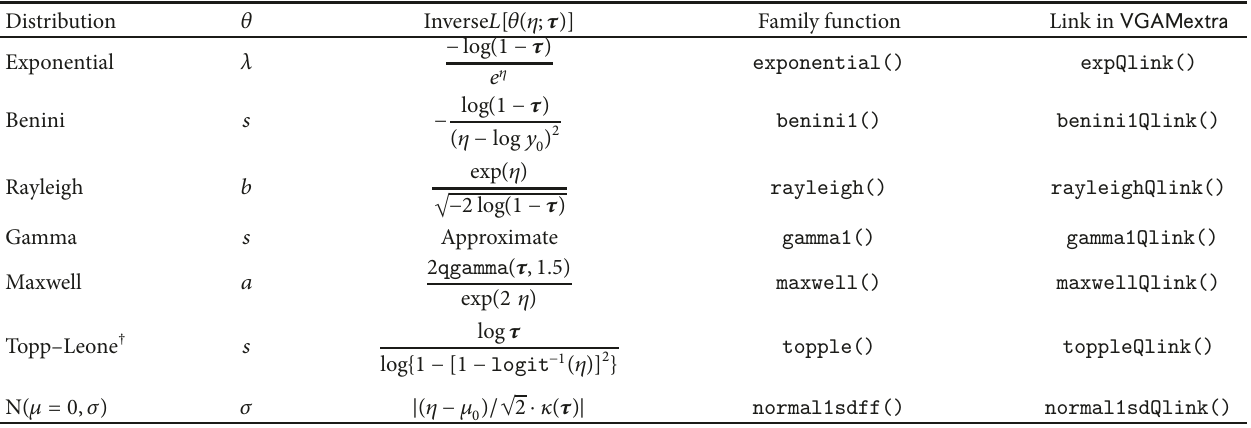
Table 3: Inverse of the quantile links and names in VGAMextra . “Approximate” means that Newton–Raphson or bisection is used to approximate the inverse. All family functions except for normal1sdff() , which is in VGAMextra , are in VGAM .